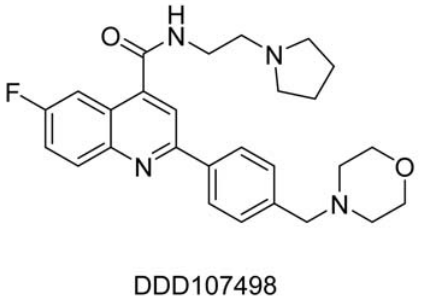
Figure 6. Structure of DDD107498